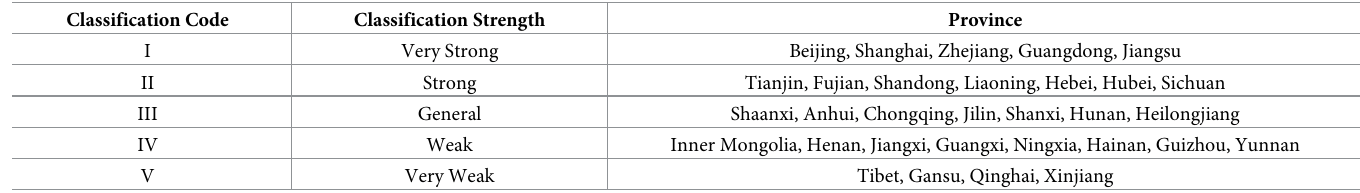
Table 15. Digital economy development level classification from 2013 to